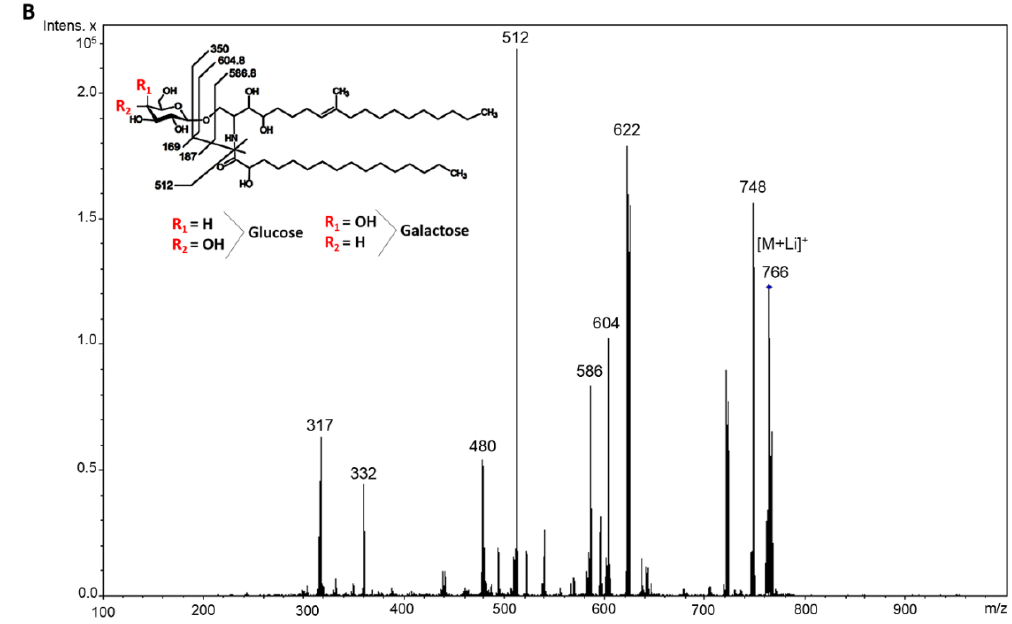
Figure 2. ESI-MS [M + Li] analysis of GlcCer/GalCer from Rhizopus species. ( A ) CMH from R. microsporus grown in PDB and YEPD, and CMH from R. stolonifer grown in YEPD. Major ions species at m / z 750. ( B ) CMH from R. stolonifer grown in PDB. Major ions species at m / z 766.